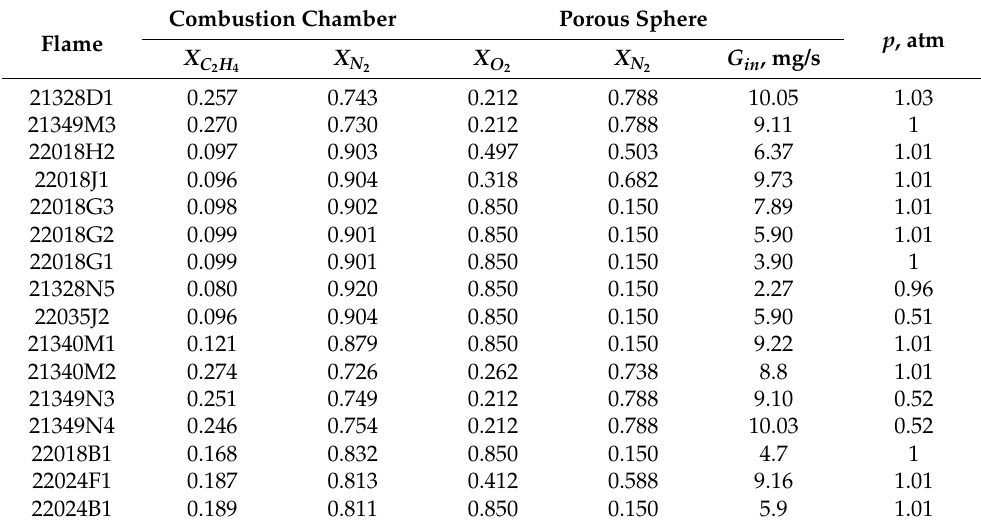
Table 3. Conditions for some inverse flames.